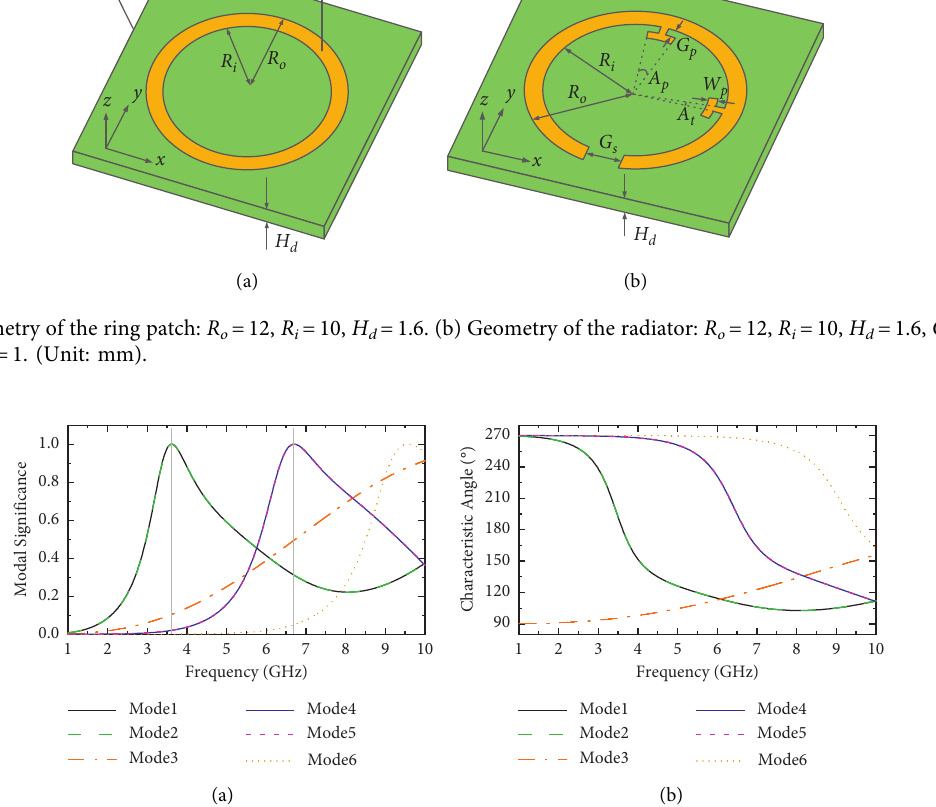
Figure 2: (a) Modal significance and (b) characteristic angle for the first six modes of the ring at